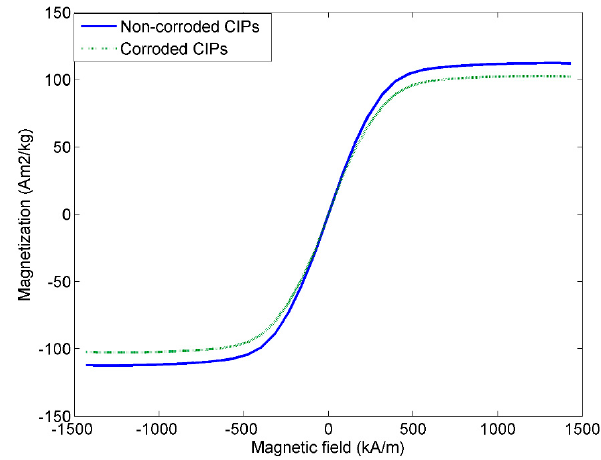
Figure 4. Magnetization curves for MRE samples of non-corroded and corroded CIPs.